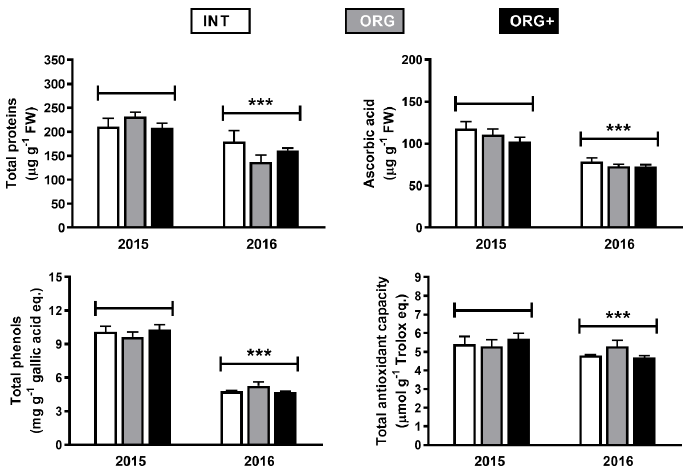
Figure 7. Total proteins, ascorbic acid, total phenols, and total antioxidant activity of apple cultivated according to three different cropping system: integrated (INT), organic farming (ORG), and